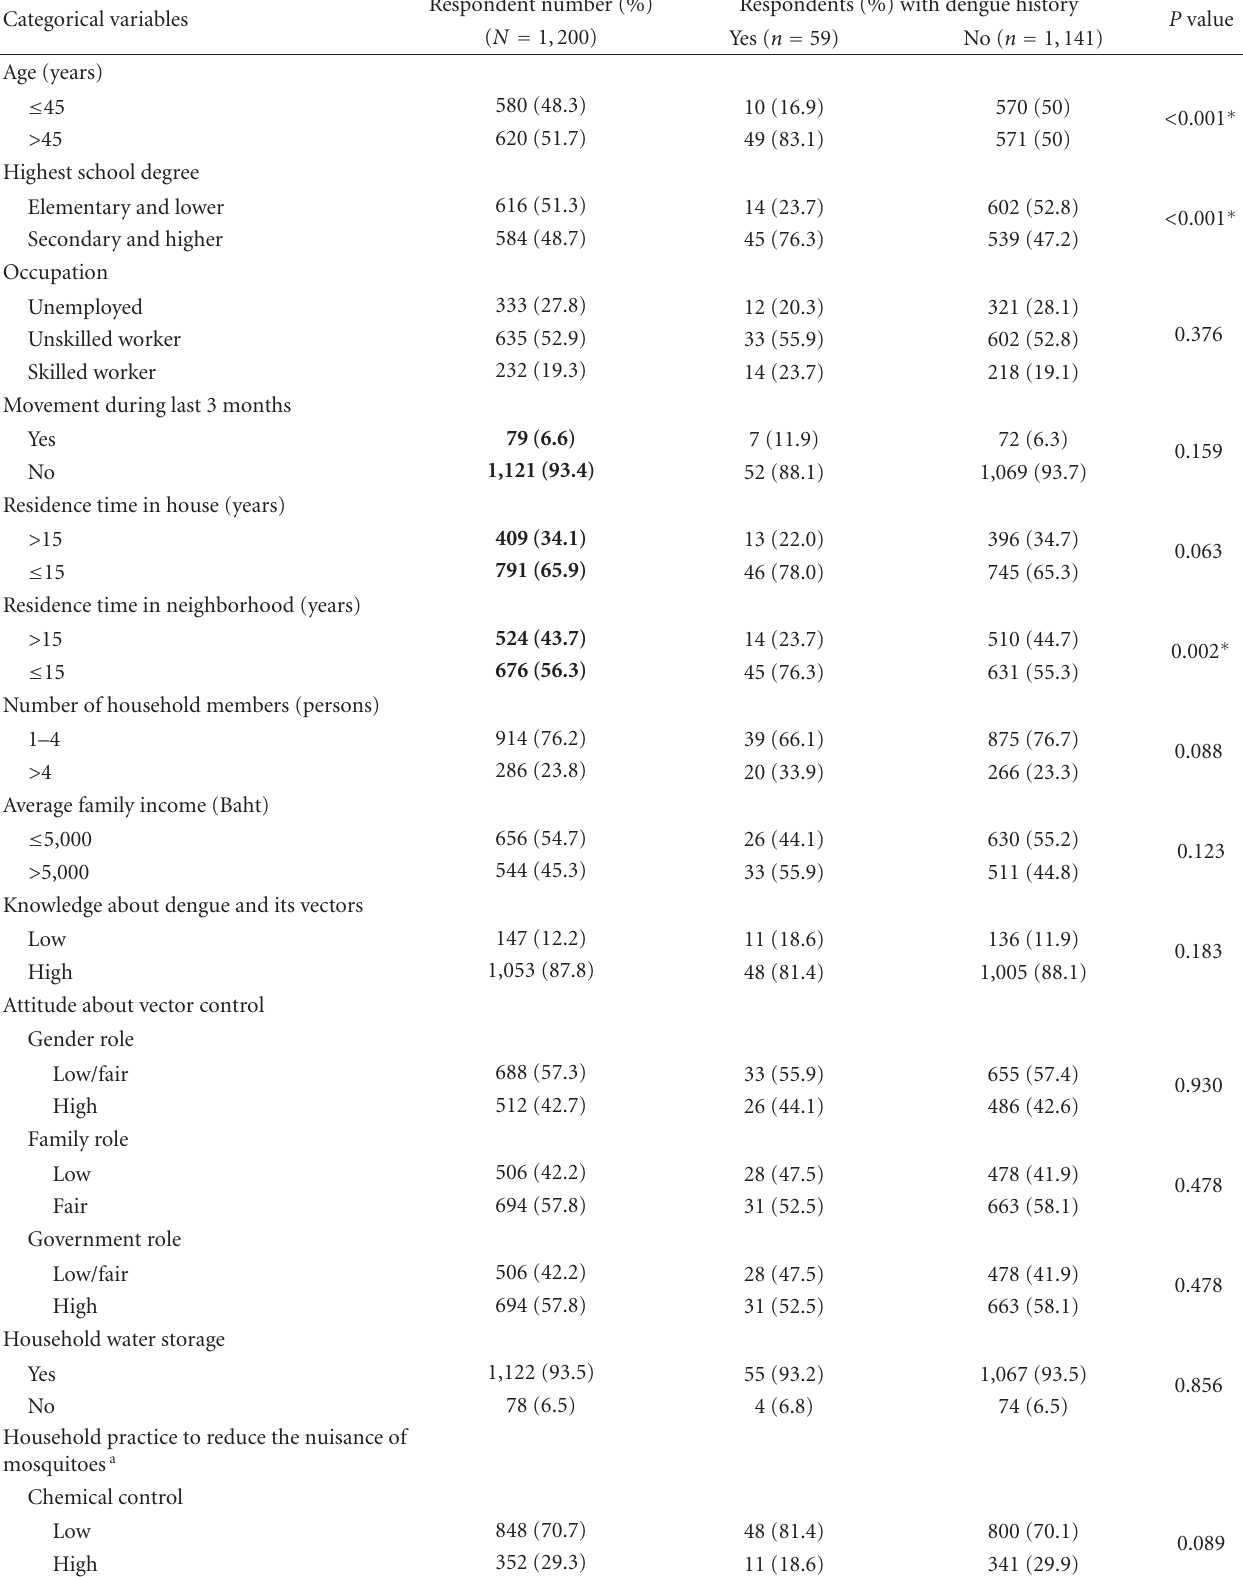
Table 3: Univariate analysis of the association between sociodemographic factors of respondents and dengue transmission. Categorical